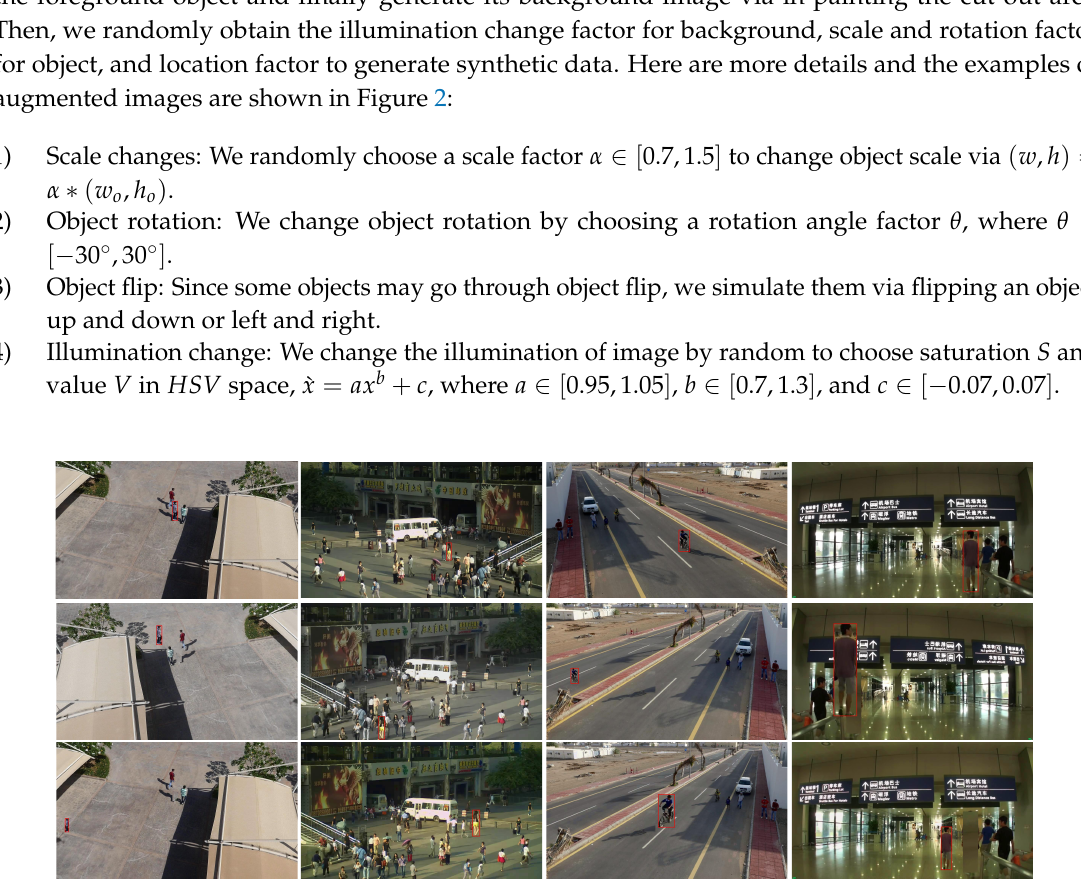
Figure 2. Examples of the augmented images. The first row images are the first frame of a test sequence, while the second and third row are the examples of the augmented images. The tracked objects are marked in a red